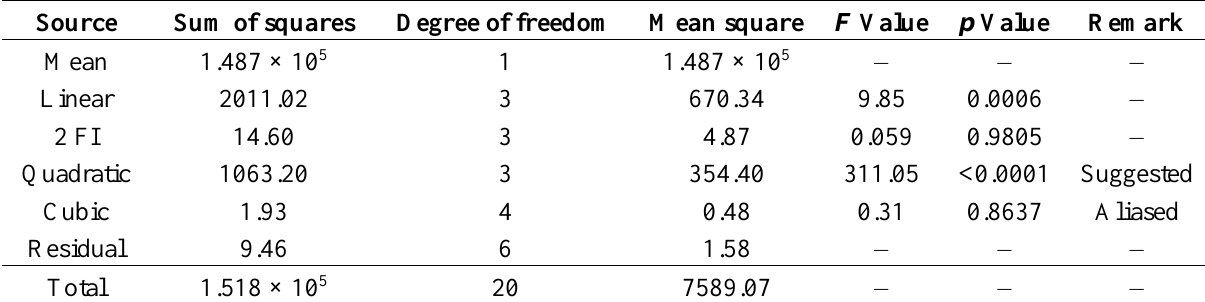
Table 3. Sequential model fitting for 4-CPA removal.